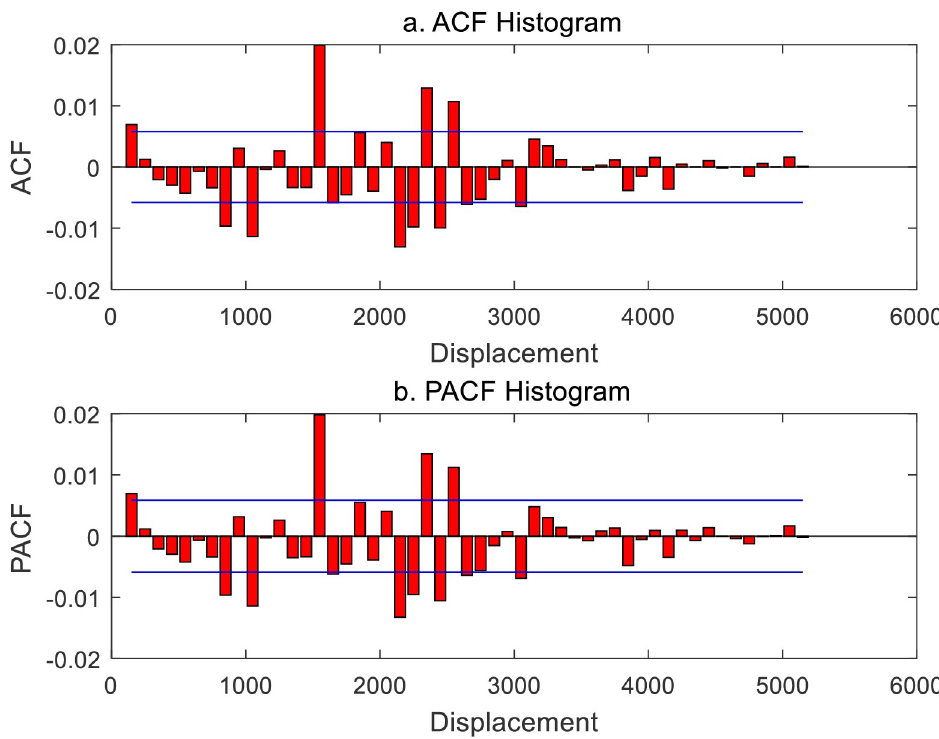
Fig 5. Spatial autocorrelation function and partial autocorrelation function of Chinese cities based on conventional Moran’s index and correlation density (2010).